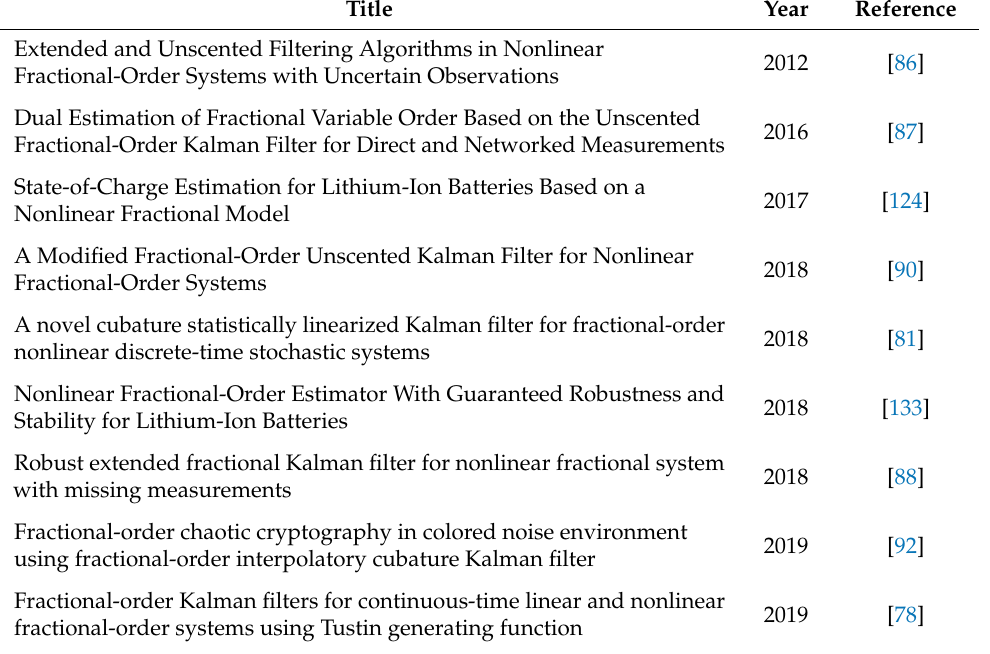
Table 1. Main fractional-order digital filter papers targeting nonlinear